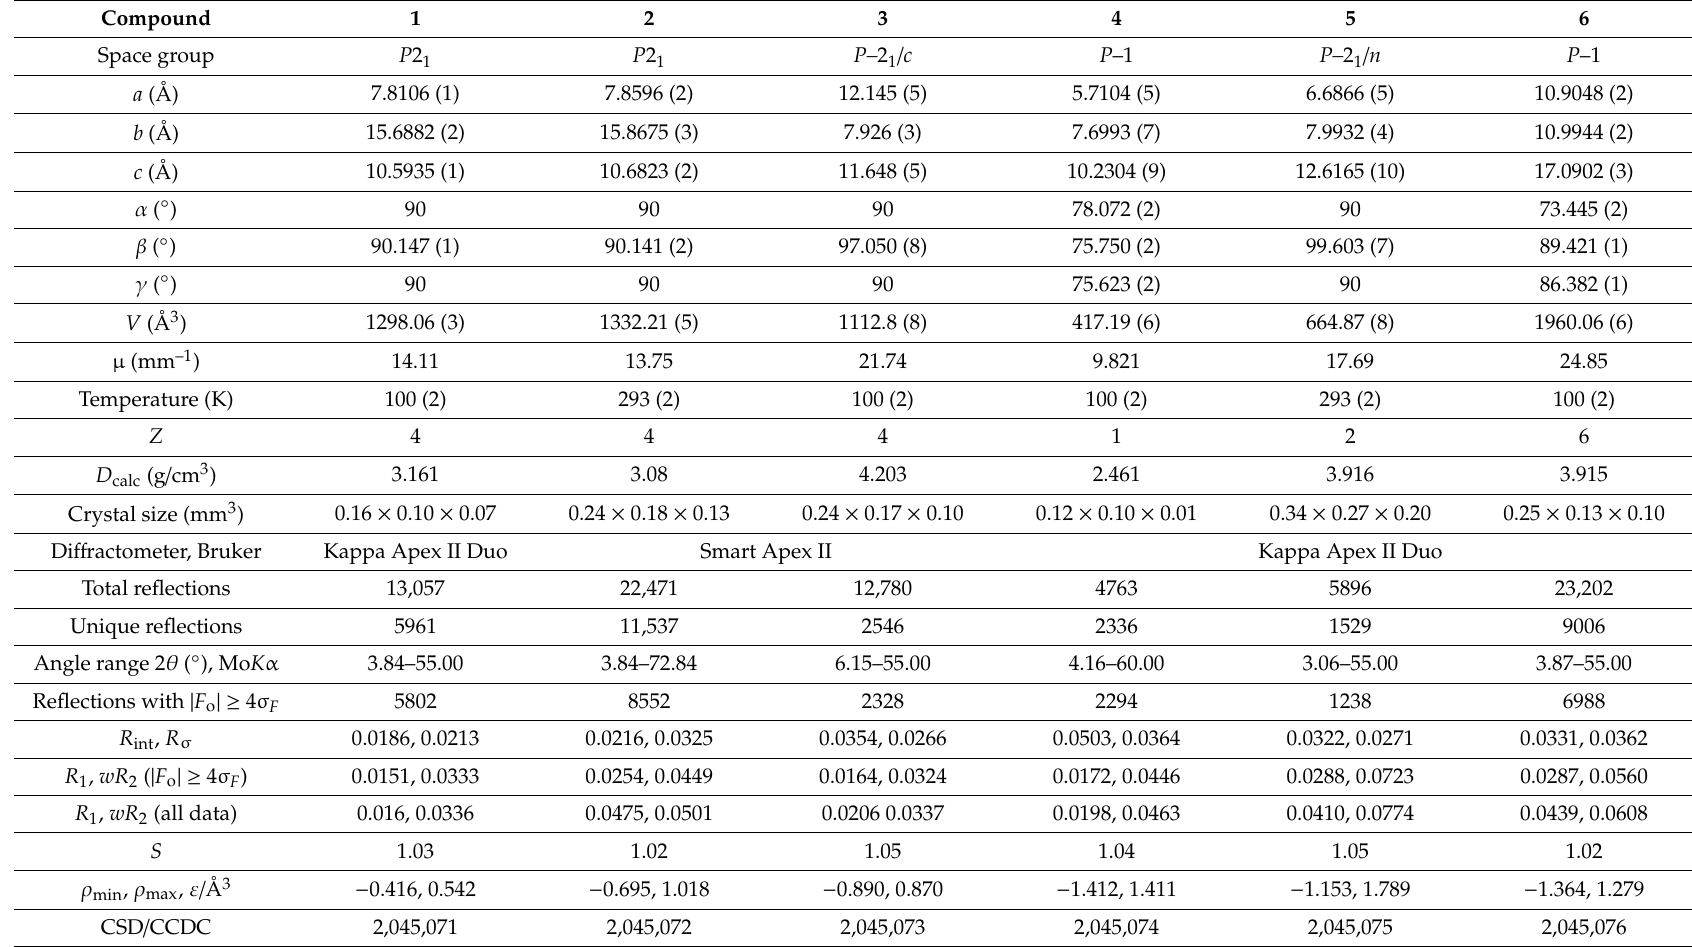
Table 1. Crystallographic data for 1 – 6